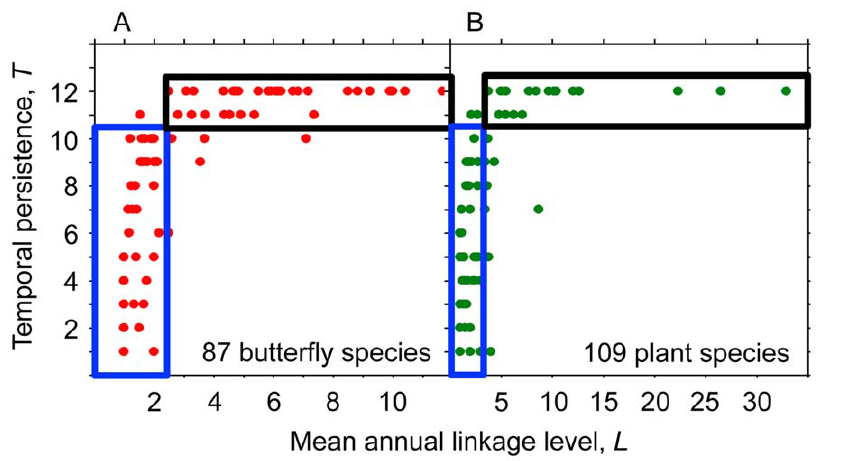
Figure 4. Relationship between temporal persistence of species and their linkage level. Relationship between temporal persistence T (no yrs observed) of butterfly species ( A ) and plant species ( B ) and their mean annual linkage level L . Two non-overlapping regions with respect to T and L were distinguished: The blue frame areas are regions of specialists, varying a lot in their T , and the black ones are regions of stable species, varying a lot in their L